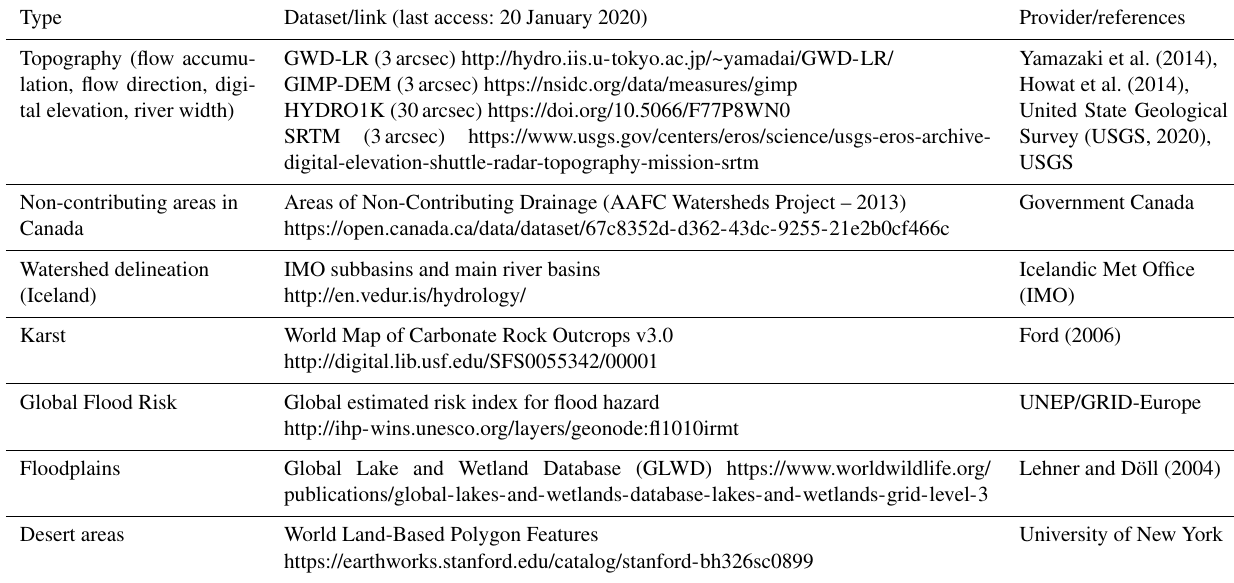
Table 1. Databases used for catchment delineation, routing, and elevation in WWH version 1.3. Type